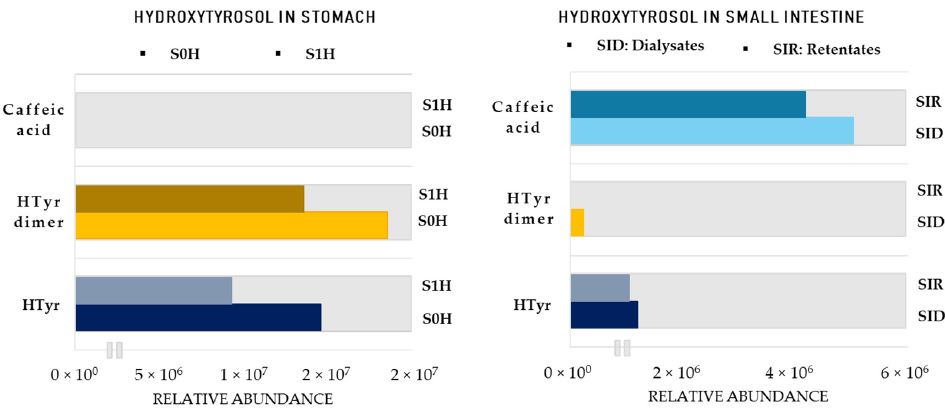
Figure 7. Area of HTyr metabolites in the stomach and small intestine. S0H : stomach T = 0 h; S1H : stomach T = 1 h; SIR : small intestine retentates, T = 1.5 h; SID : small intestine dialysates, T = 1.5 h. HTyr dimer : Htyr26 .